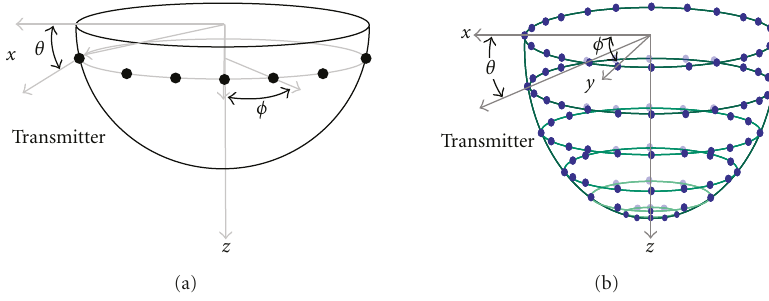
Figure 7: Multibeam transmitter structures for (a) 180-degrees ring shape and (b) hemisphere. Table 1: Simulation parameters for a typical di ff usive optical channel with one transmitter located at the ceiling. Parameter Value Transmitter elevation angle and azimuth angle ( θ , φ ) (30, 0)